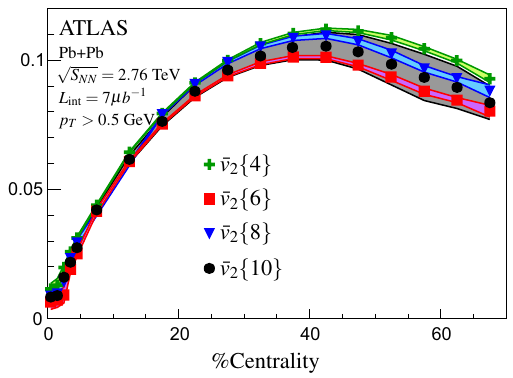
Fig. 5 The quantity δ 2 k for k = 2 , 3 , 4 and 5 with respect to centrality class